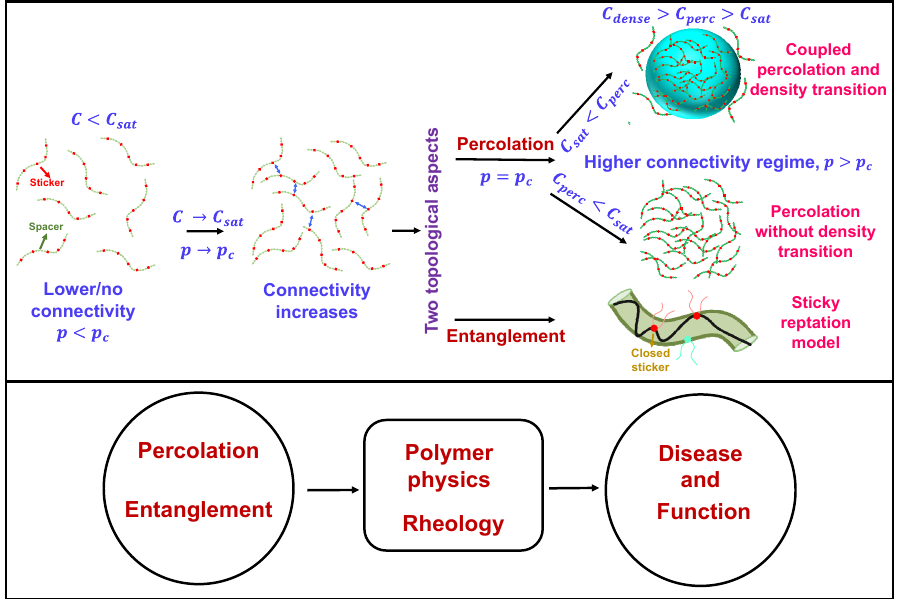
Figure 1. General overview of two topological concepts discussed here, namely percolation and entanglement in the context of biomolecular condensation. In the upper panel (on left side) the red circles describe the stickers and the green circles constitute the spacer. The blue two-sided arrows describe sticker-sticker interactions. On right side, the droplet has been shown by a light blue sphere with color coded intersticker interactions. In the ‘sticky reptation model’ the polymer chain confined in the tube (olive) is shown by a black strand. The red circles with strand describe the ‘closed stickers’ and cyan circles describes the next available polymer (sticker) chain for reptation depending upon the chain diffusion pattern. This concept has been discussed in detail in later sections of this